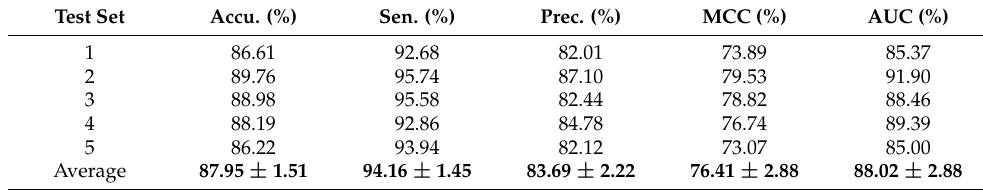
Table 4. MSPEDTI outcomes for 5CV on GPCR dataset.